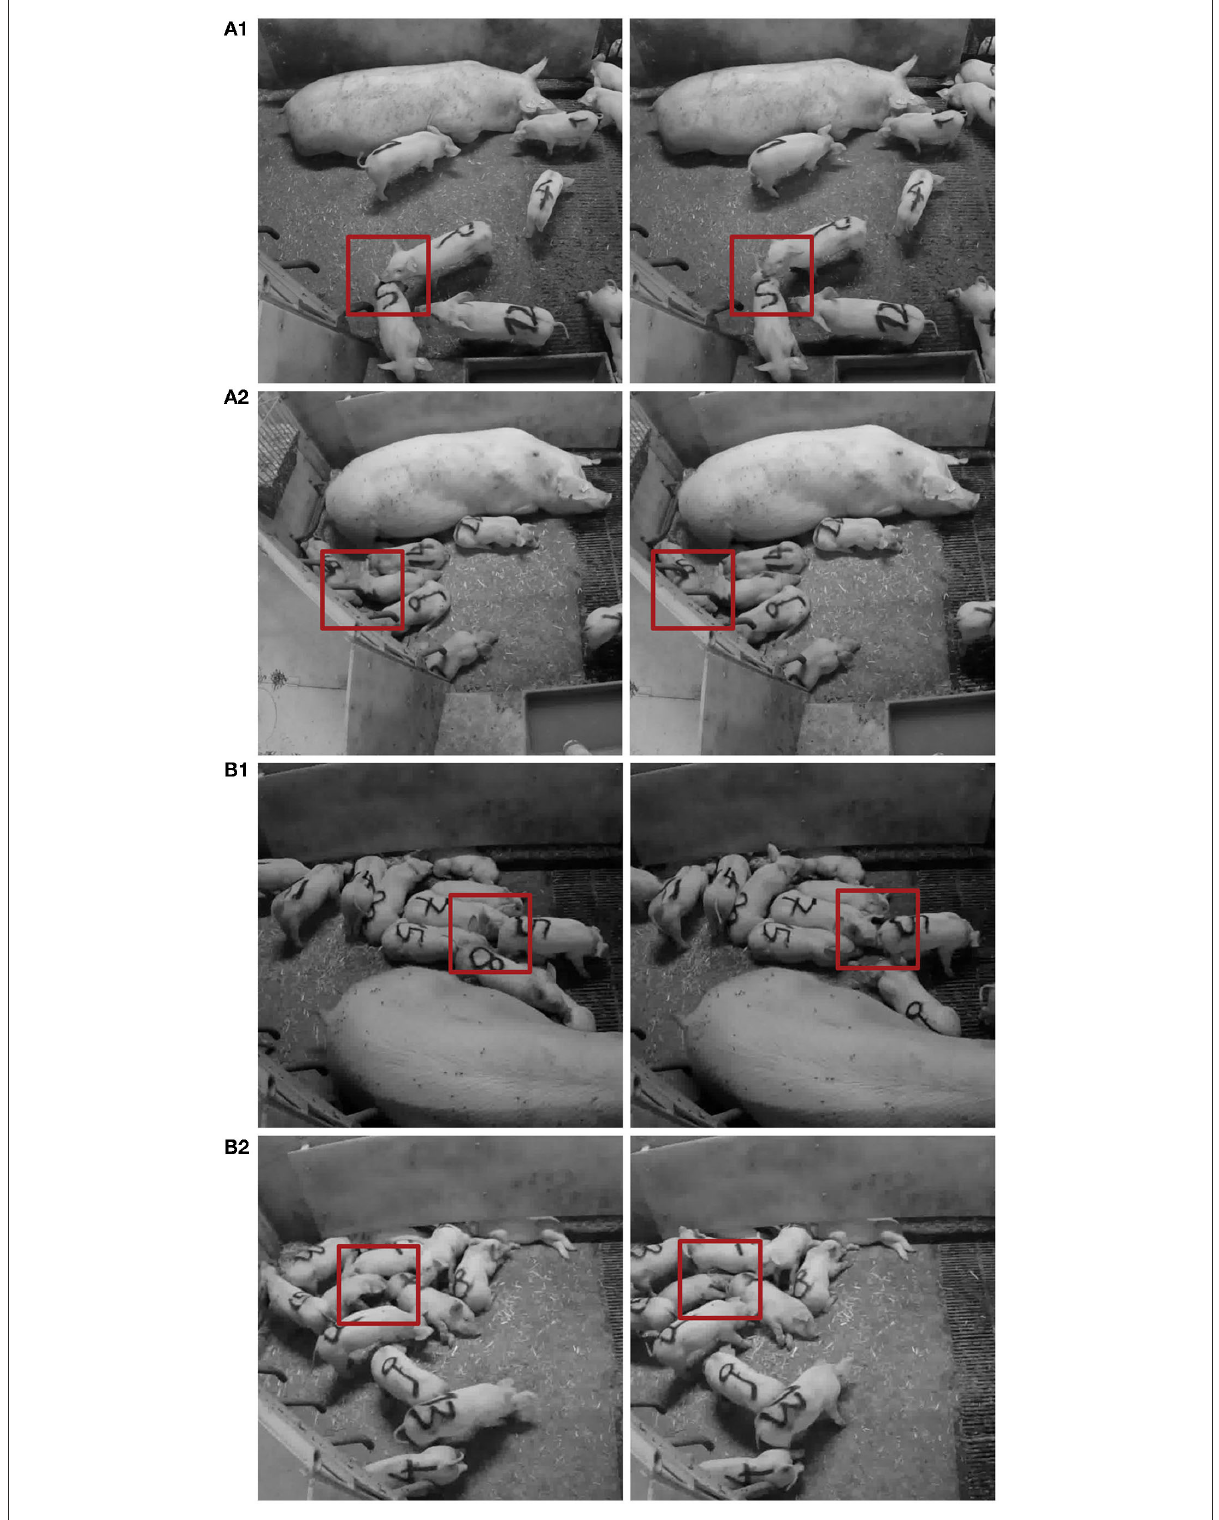
FIGURE6 Examples of FP (1) and FN (2) classifications of tail-biting behavior of the final LSTM (A) and CNN (B) model from subsequent frames. Red rectangles indicate the area of potential